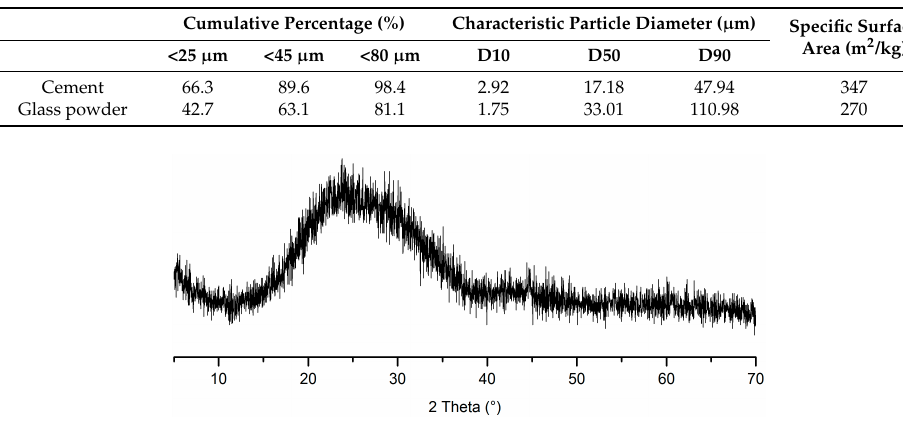
Figure 5. X-ray diffraction pattern of glass powder.